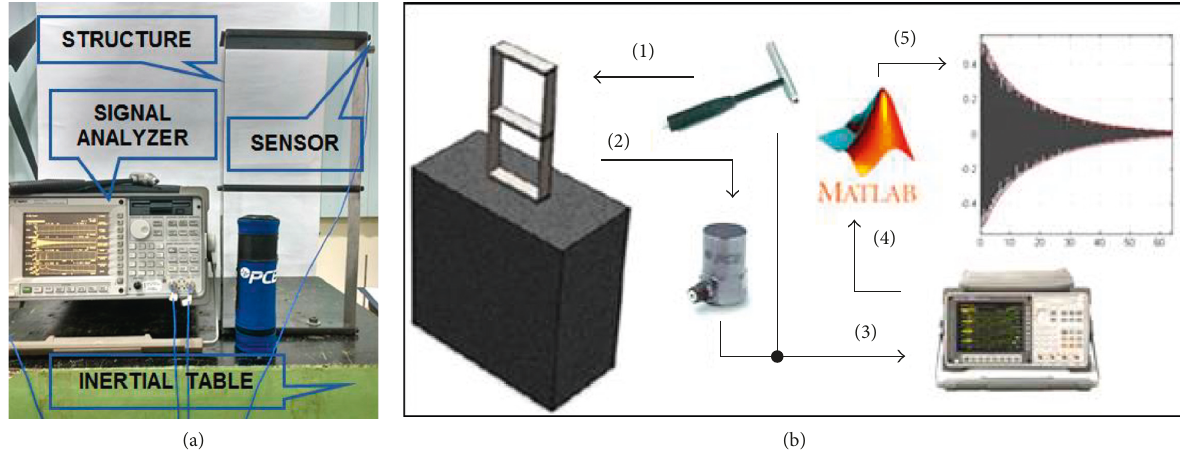
Figure 7: (a) Experimental setup of the structure tests in free vibration and (b) schematic representation of the experimental procedure in the free vibration tests.